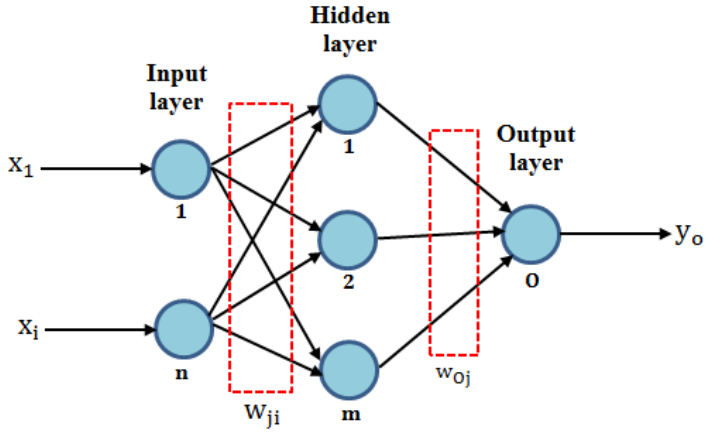
Figure 3. Three-layer neural network.